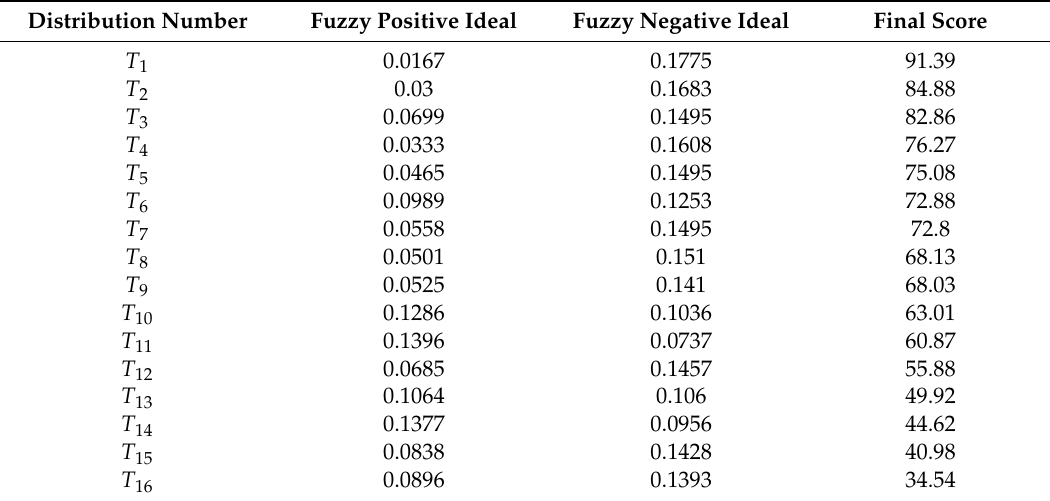
Table 8. Results of distribution transformer status